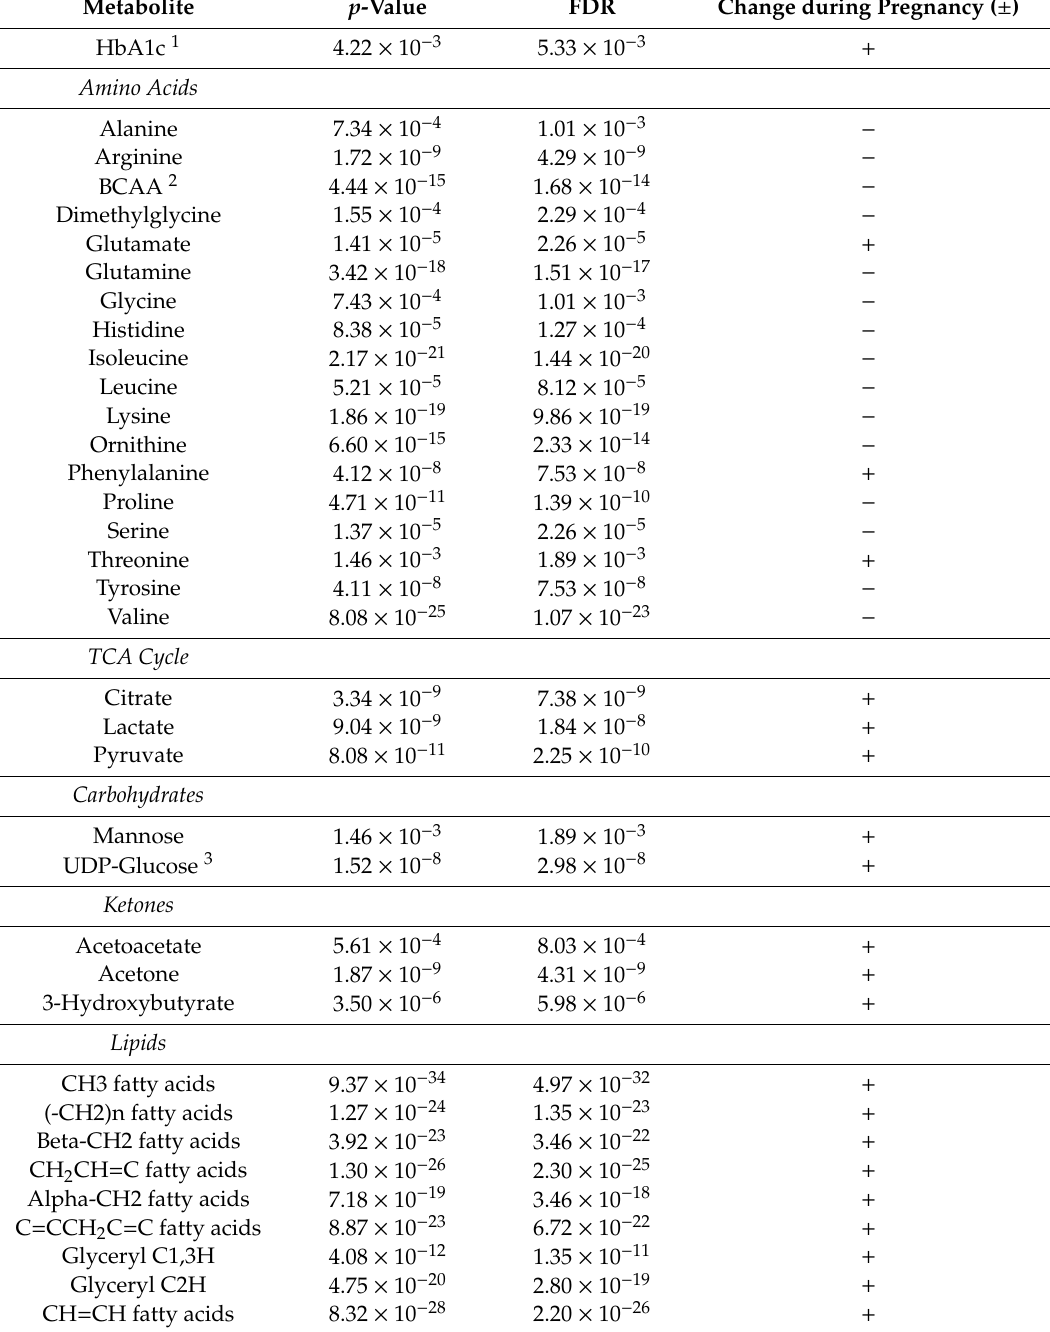
Table 1. Significantly Altered Metabolites over Gestation, Regardless of Diabetes